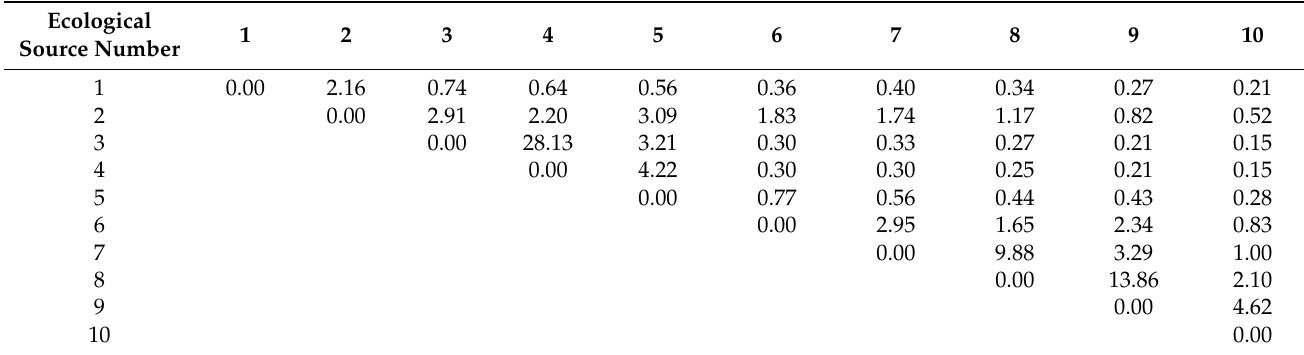
Table 8. Interaction intensity of the ecological